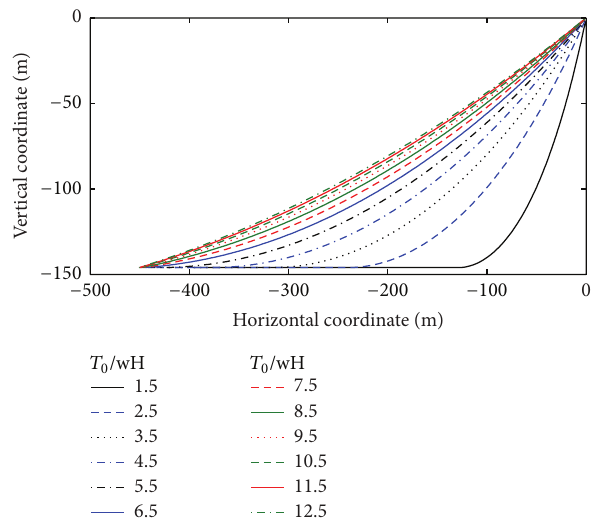
Table 2: Properties of ITI Energy